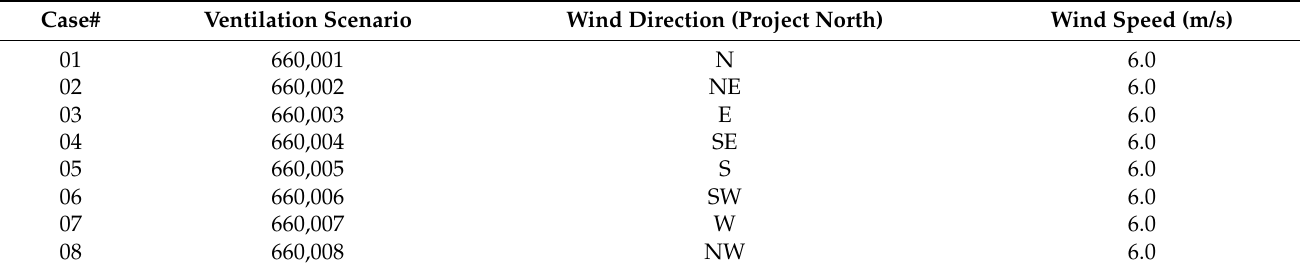
Table 2. CFD ventilation simulations